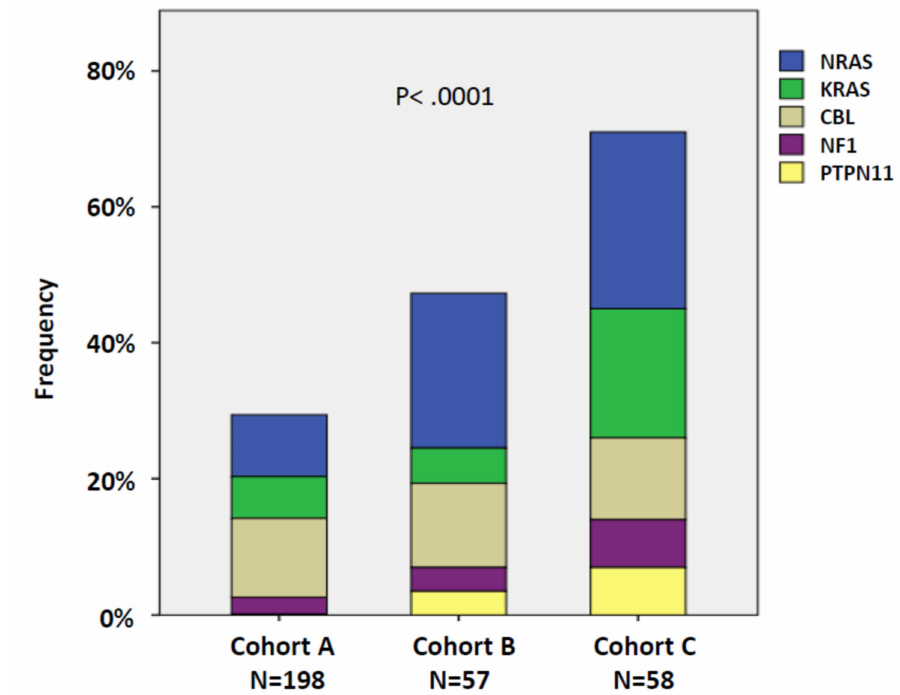
Figure 1. Frequencies of RASopathy gene mutations in the 3 patient cohorts: patients without evidence of progression (cohort A), patients who developed disease progression (transformation and / or disease-related death) during follow up (cohort B), and patients who had already transformed to secondary acute myeloid leukemia (AML) at the time of sampling (cohort C). Individual genes are indicated by di ff erent colors. Cohort C includes 18 patients from cohort B who initially had no evidence of transformation but developed AML during observation. In patients with more than one mutation in RASopathy genes the mutation with the highest variant allele frequency (VAF) was used for this analysis.